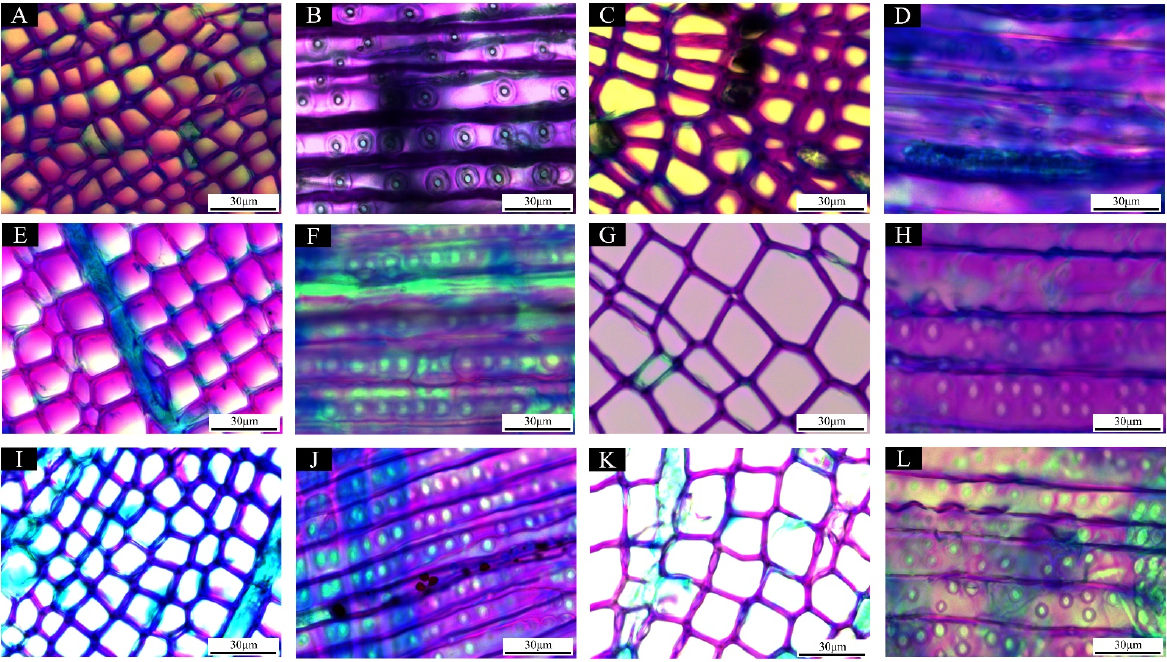
Figure 2. Tracheid and pit photographs of the branch and root xylem in the three taxa (×400). Scale: